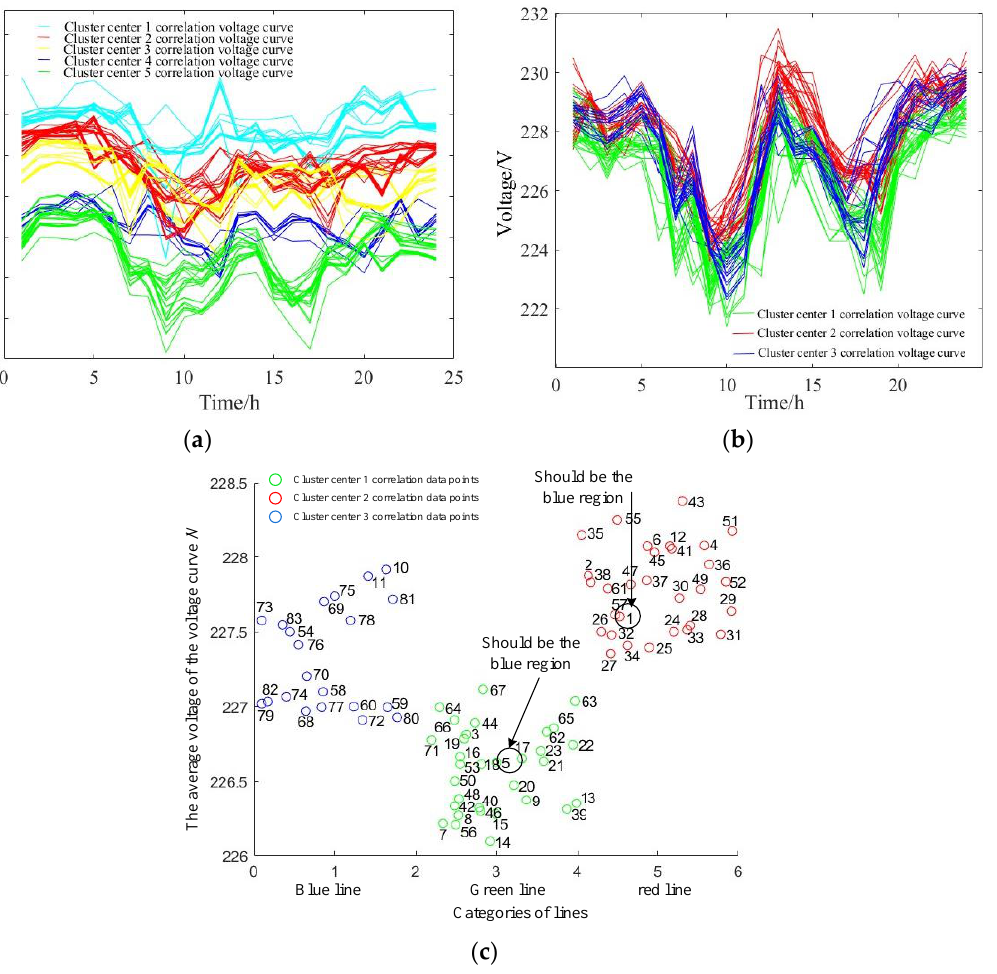
Figure 9. B-phase user voltage correlation coefficient curve.